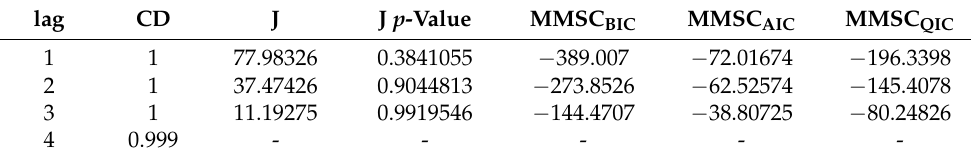
Table 5. Order selection table.